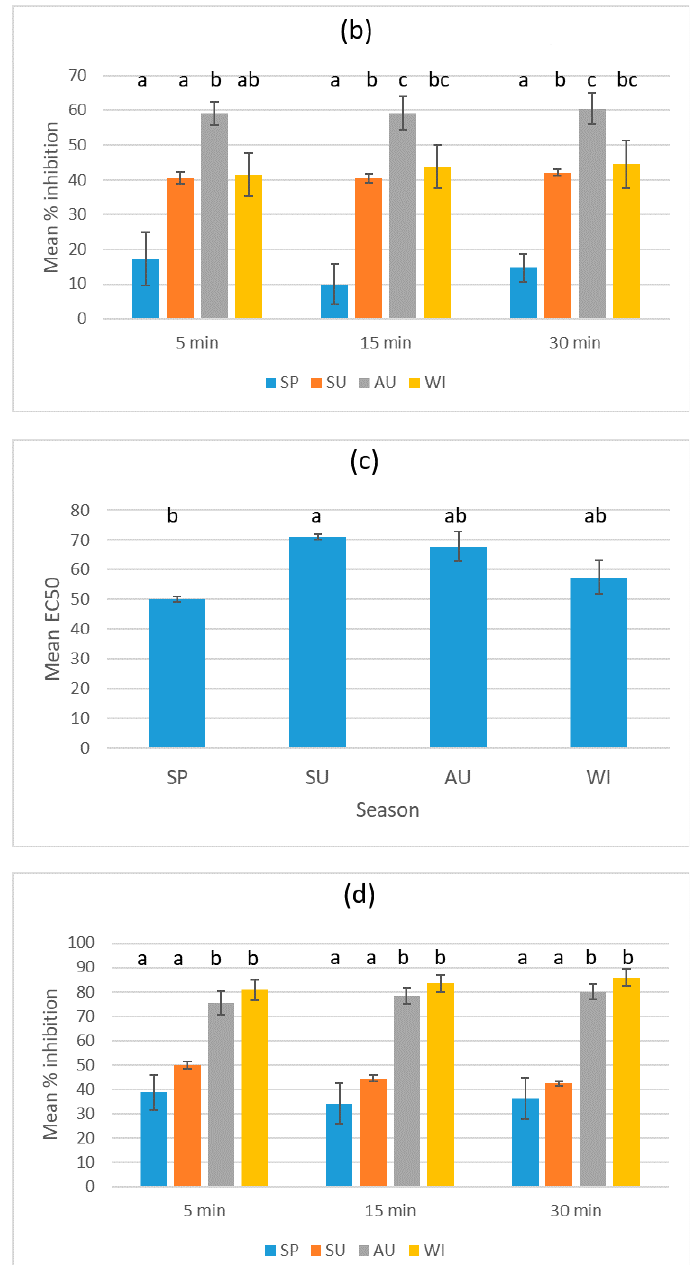
Figure 1. EC50 values for D. magna for each season ( a , c ) and % inhibition values for V. fischeri for each season ( b , d ) for EN 12457-2 leaching test ( a , b ) and NEN 7341 leaching test ( c , d ). No EC50 could be calculated for AU sample in Figure 1a. Key: different letters denote statistically significant differences between the tested groups (repeated measures ANOVA followed by post-hoc HSD test).